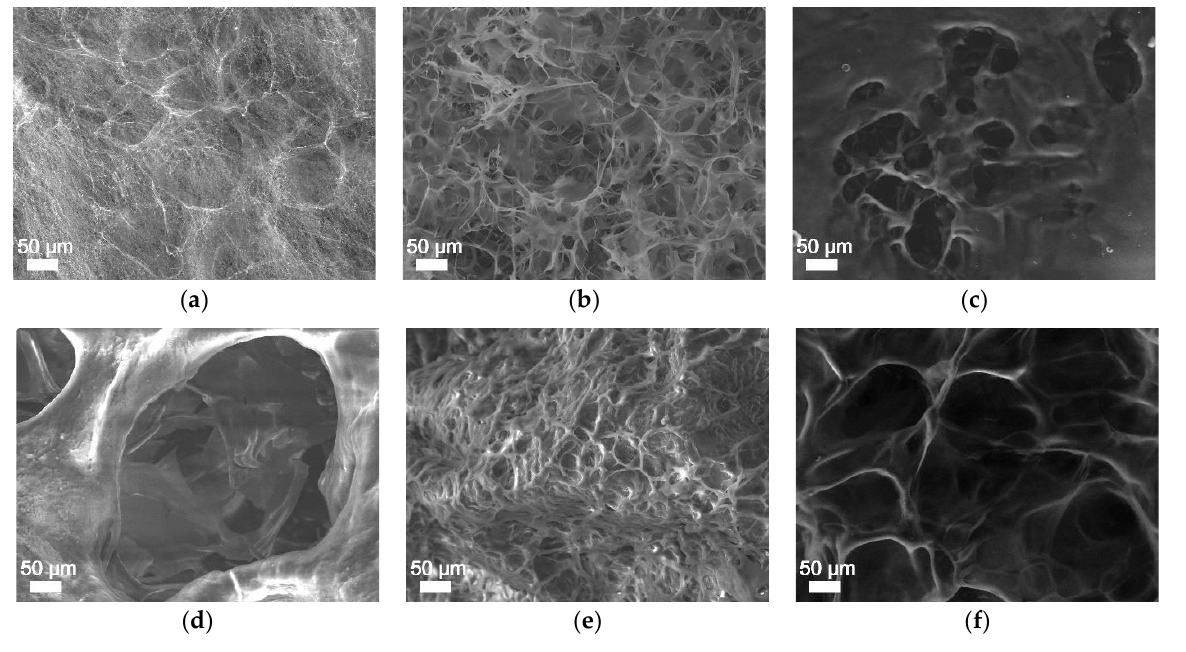
Figure 9. SEM images of surfaces of ( a ) gelatin; Gel-PMMA copolymers synthesized in the presence of ( b ) AIBN; ( c ) AIBN and TBB; ( d ) AIBN, TBB, and 2,5-DTBQ; ( e ) TBB and 2,5-DTBQ (Gel:MMA = 1:10); ( f ) TBB and 2,5-DTBQ (Gel:MMA = 1:1).